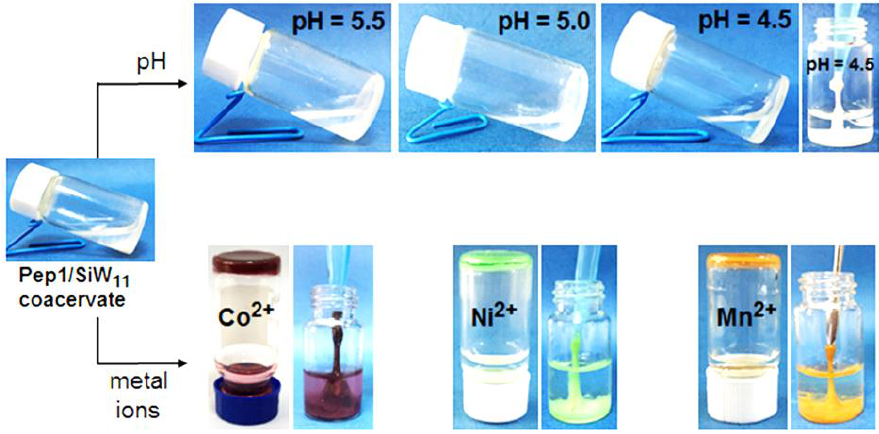
Figure 7. pH and metal–ion responsiveness of a coacervate based on a peptide (Pep1) and POMs (SiW 11 ). Adapted with permission from [66]. Copyright © 2019, American Chemical Society.